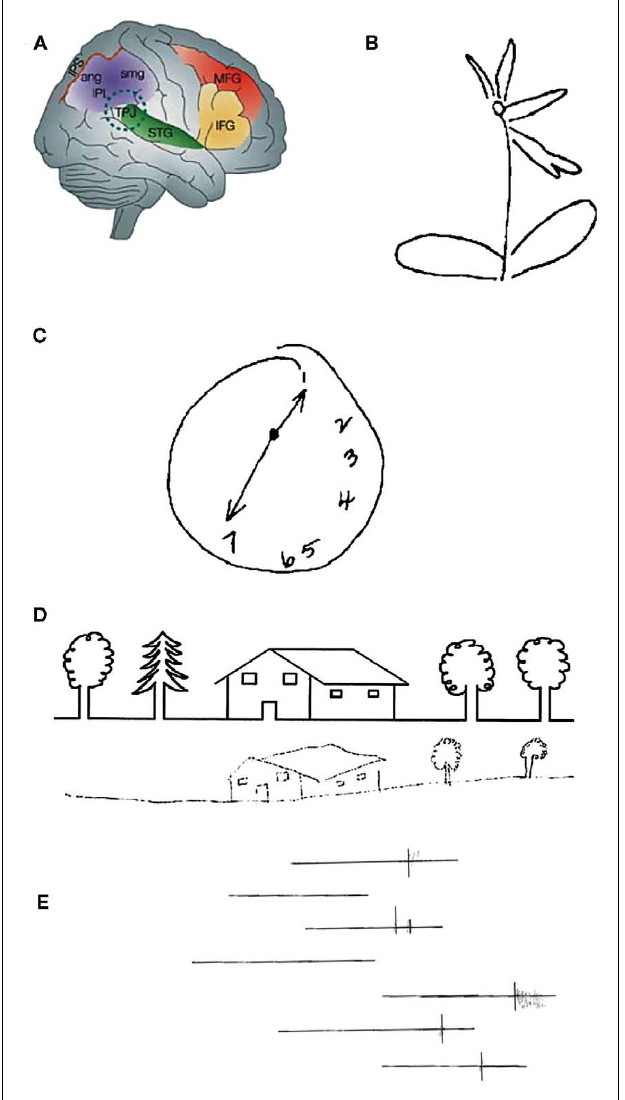
FIGURE 1 |Visuo-spatial hemineglect (HN). (A) Location of brain damage in patients with visuo-spatial HN (after Halligan and Marshall, 2001). (B) Example of object-centered HN. (C) Example of clock test drawing by a patient with HN. (D) Landscape test (top) with example of drawing by a patient with HN. (E) Line bisection task with drawing by a patient with HN showing rightward deviations and omitted lines on the